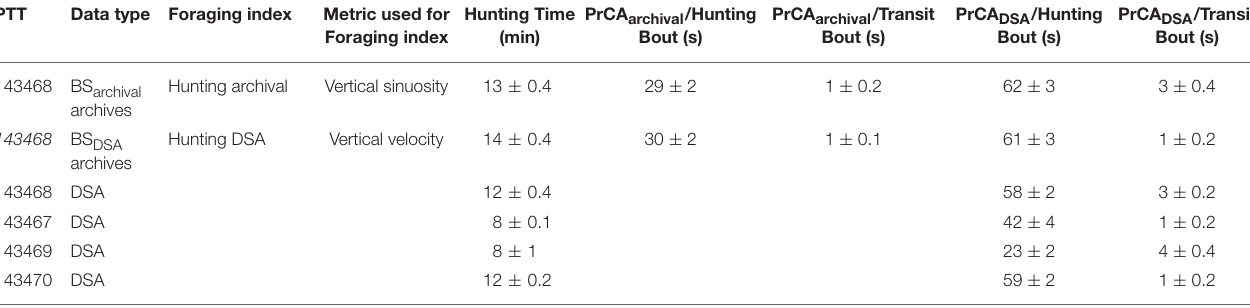
TABLE 3 | Foraging effort outputs from the calculation of high and low-resolution effort indices. PTT Data type Foraging index